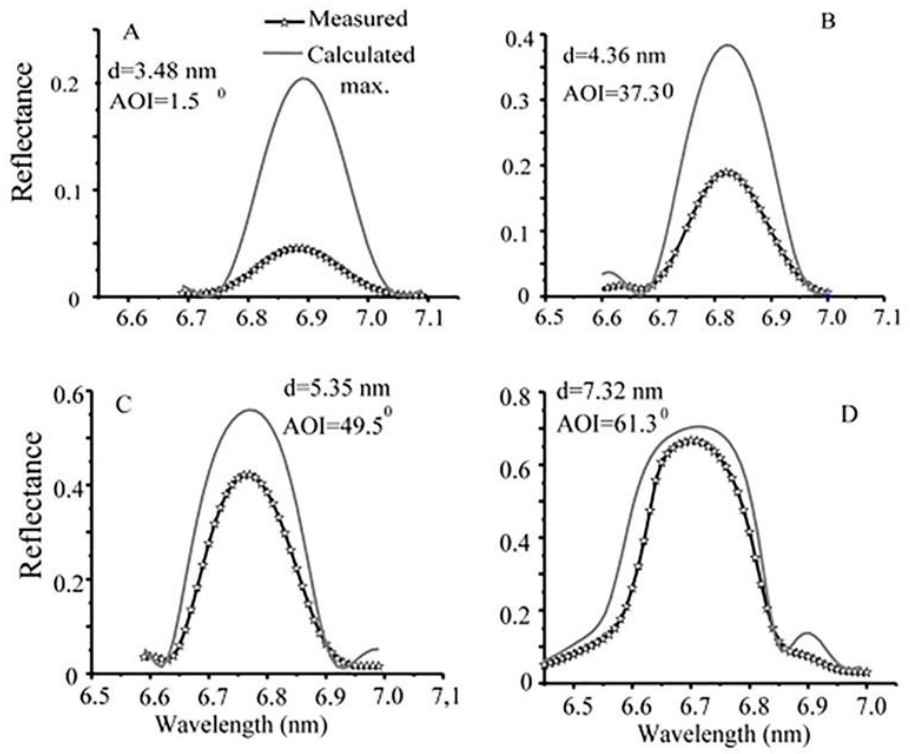
Figure 7. Calculated and measured BEUV reflectivity for e-beam deposited 40 period La/B PMMs with different periods. Reprinted with permission from [28] © The Optical Society.